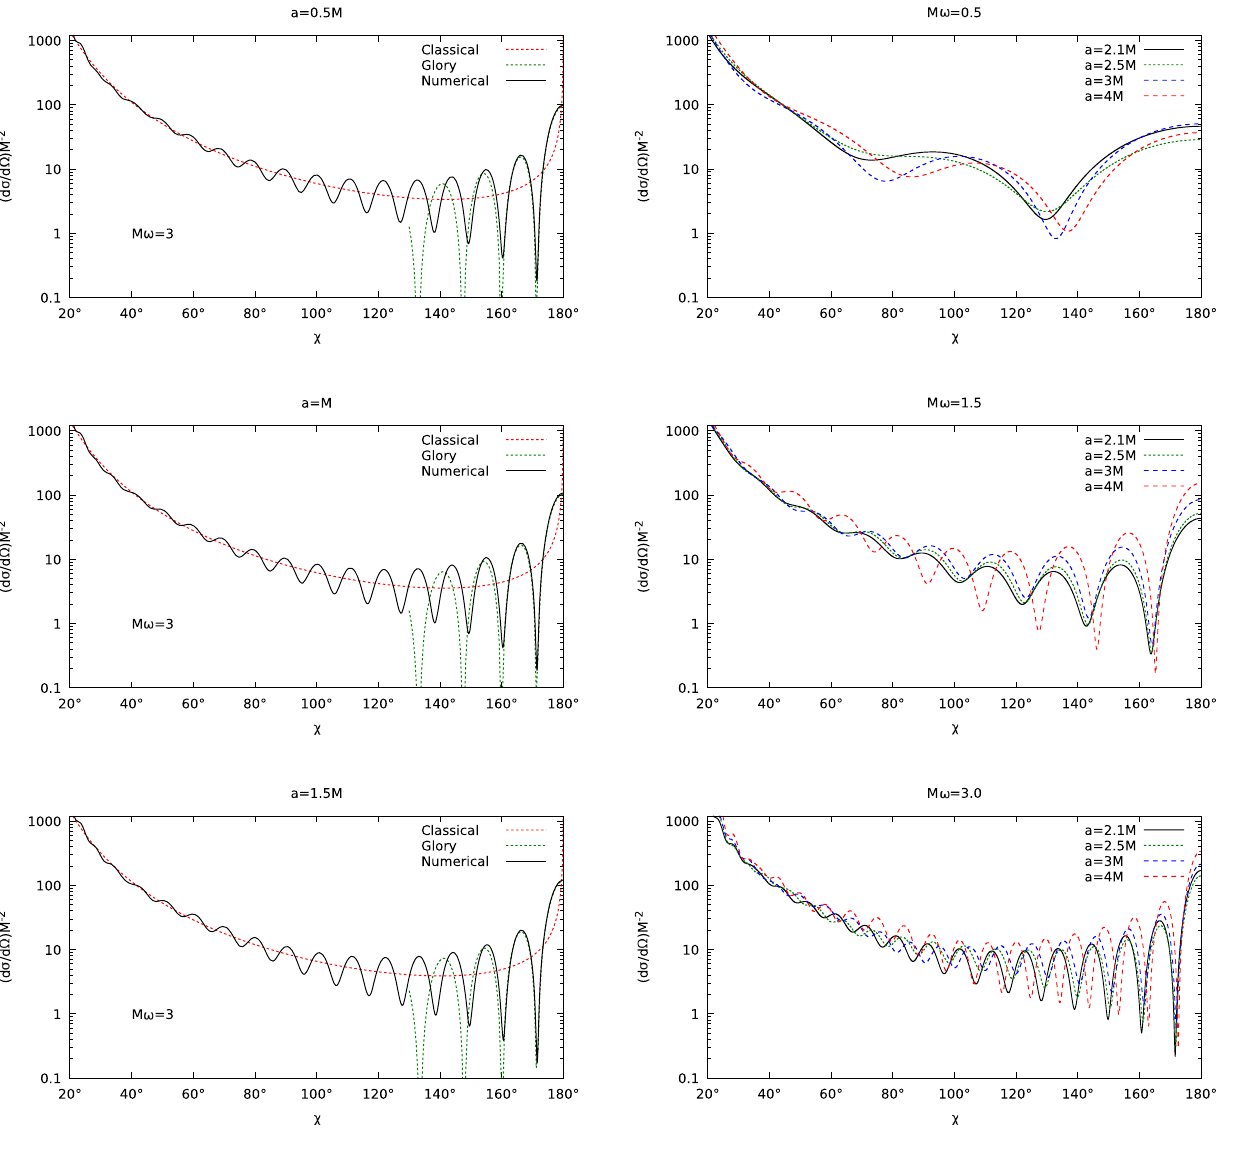
Fig. 4 Comparisonbetweenthescalardifferentialscatteringcrosssec- tion of Simpson–Visser regular black holes obtained by the classical scattering, the glory scattering approximation and the full numerical analysis for M ω = 3 and different values of a / M